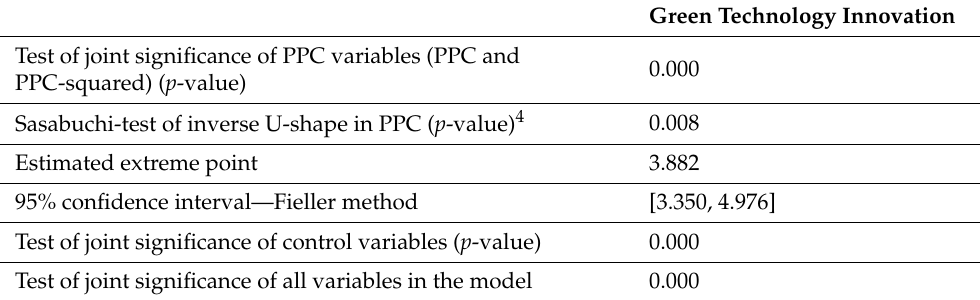
Table 5. Test of an inversely U-shaped relationship between environmental regulation and green technology